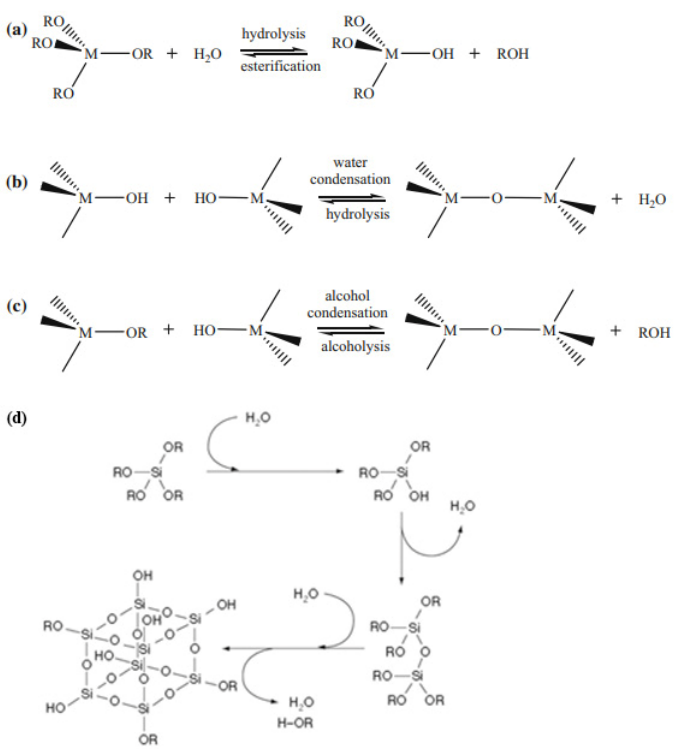
Figure 1. Hydrolysis ( a ) and condensation ( b , c ) of metal alkoxides. Reprinted with permission from [14]. ( d ) Formation of silica from tetra alkoxysilanes by hydrolysis and condensation. R alkyl, usually methyl, ethyl, or isopropyl groups. Reprinted with permission from [15].